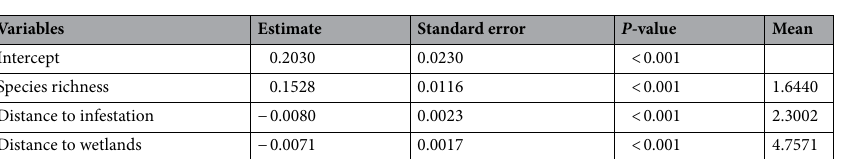
Table 2. Multiple Linear Regression model to predict density (number of plants/m 2 ) using plant species richness (number of plant species), distance to the closest infestation (m), and distance to the closest wetland (m) as predictor variables (n = 1673). Cube root transformation was implemented for all the variables used in the model to normalize the